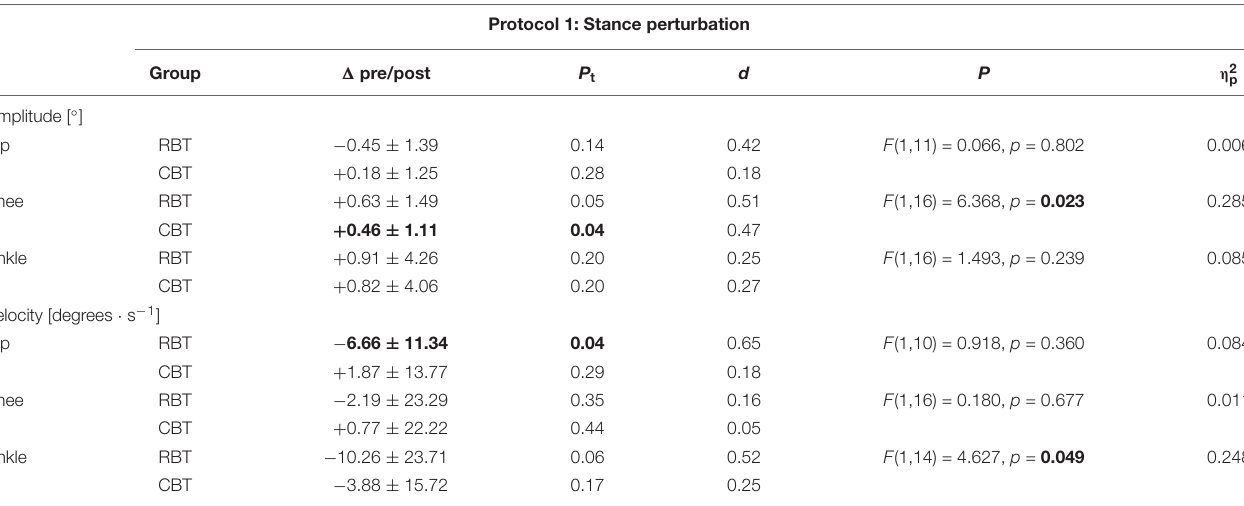
TABLE 3 | Kinematic data during stance